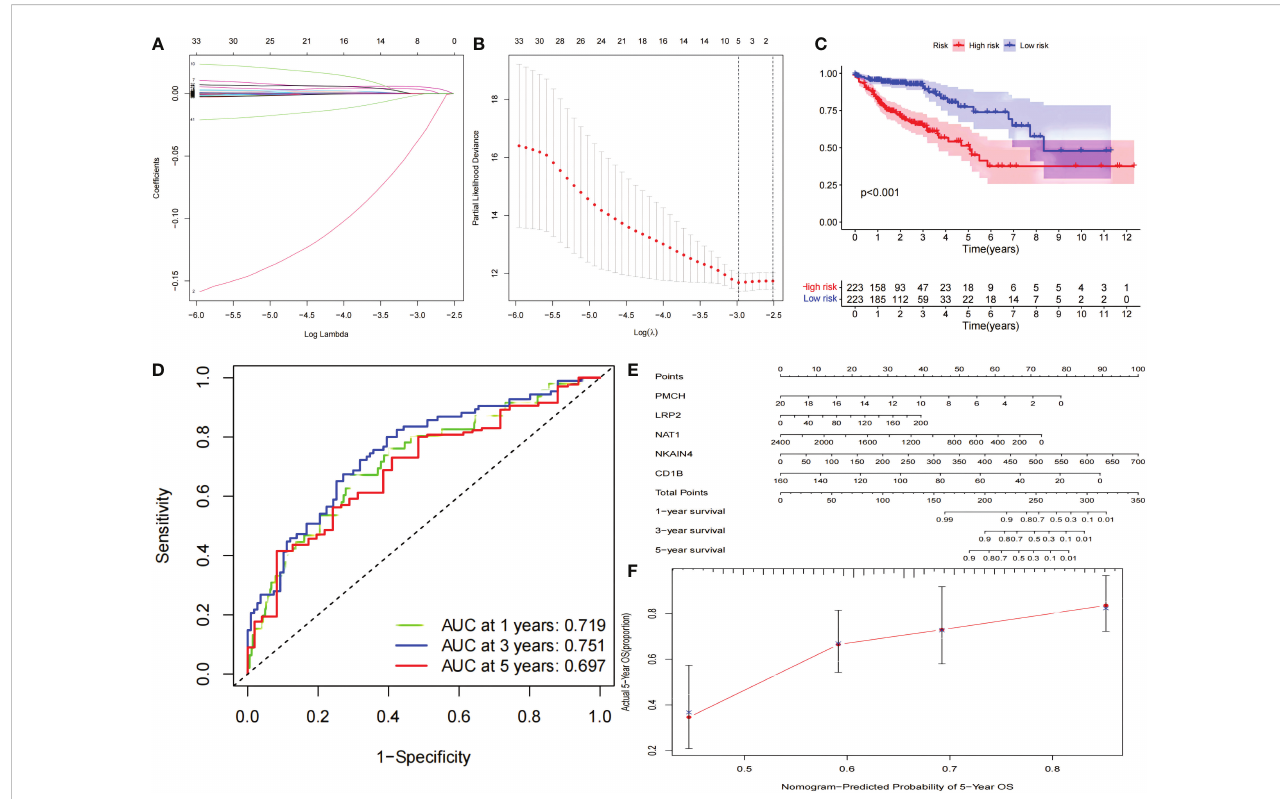
FIGURE 3 The PPI network signature. The PPI network signature was constructed based on the components of the PPI network associated with survival according to LASSO-Cox regression analysis (A, B) . Kaplan-Meier survival curve (C) , The results of ROC curve (D) , nomogram (E) , and calibration curve (F) analyses are shown. LASSO, least absolute shrinkage and selection operator; ROC, receiver operating characteristic; PPI, protein-protein